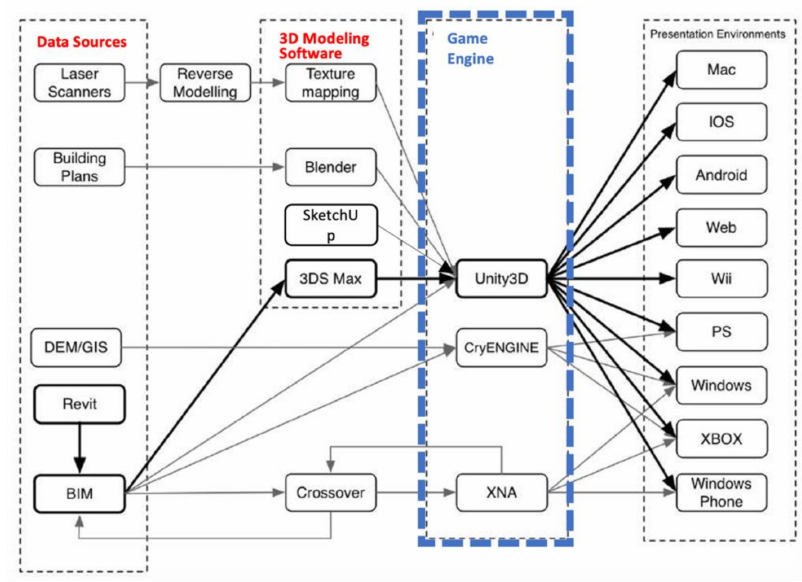
Figure 1. Research trend of integrated hybrid modeling technology (sources: